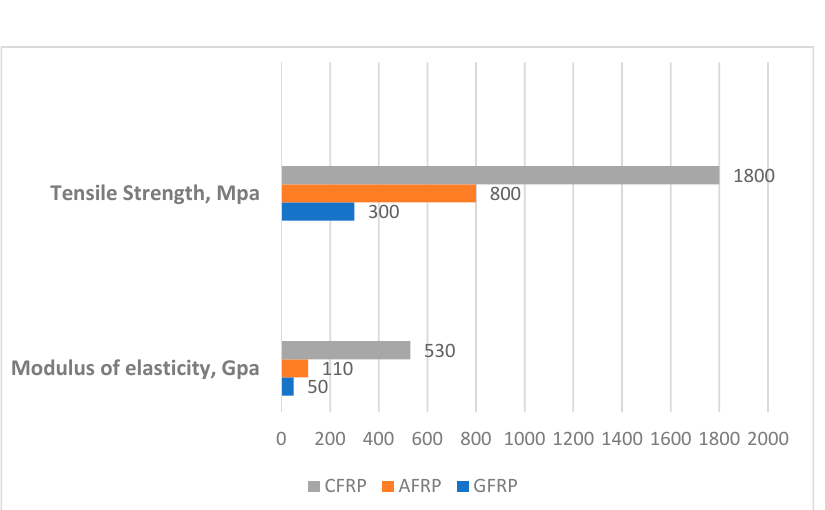
Figure 5. Comparison of design tensile strength and elasticity modulus of different types of fibers. Table 1. Physical and mechanical properties of different FRPs, adapted from Refs. [7,8].